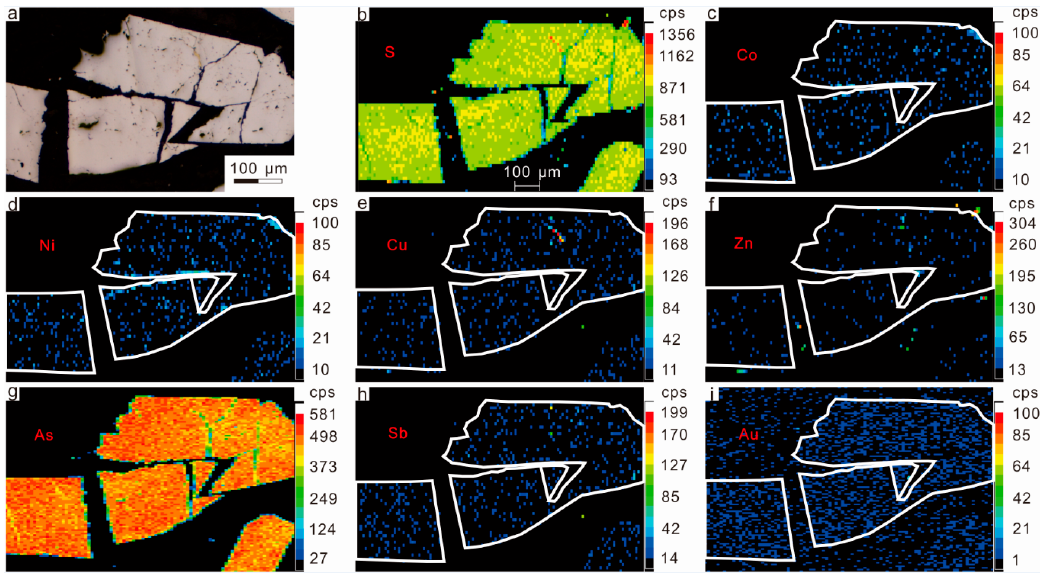
Figure 6. ( a ) Photomicrographs showing mineralogical features of the arsenopyrite selected to measure; ( b–i ) X-ray elements distribution maps of S, Co, Ni, Cu, Zn, As, Sb and Au.